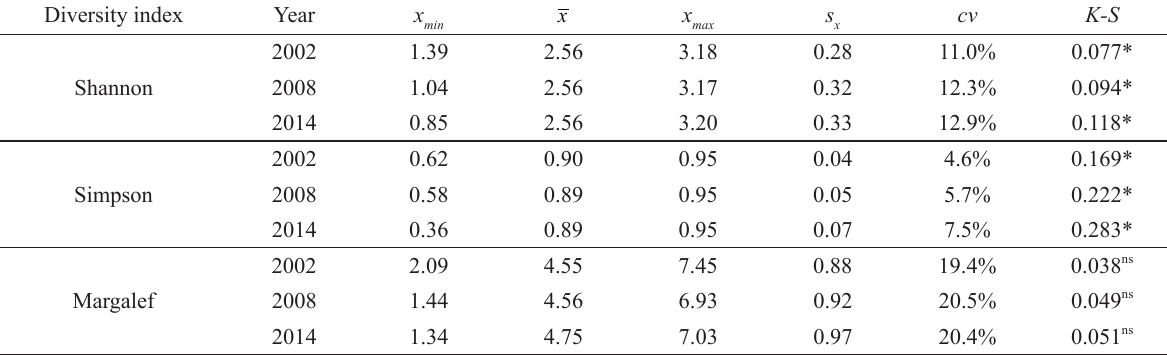
Descriptive statistics of diversity indices in a mixed tropical forest remnant in the Southern region of